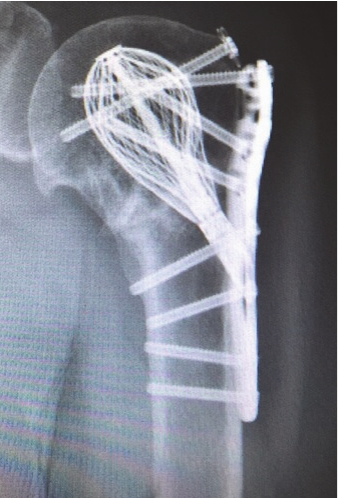
Figure 2: Radiograph at 6-month follow-up after fixation using a PH Cage and side plate construct.